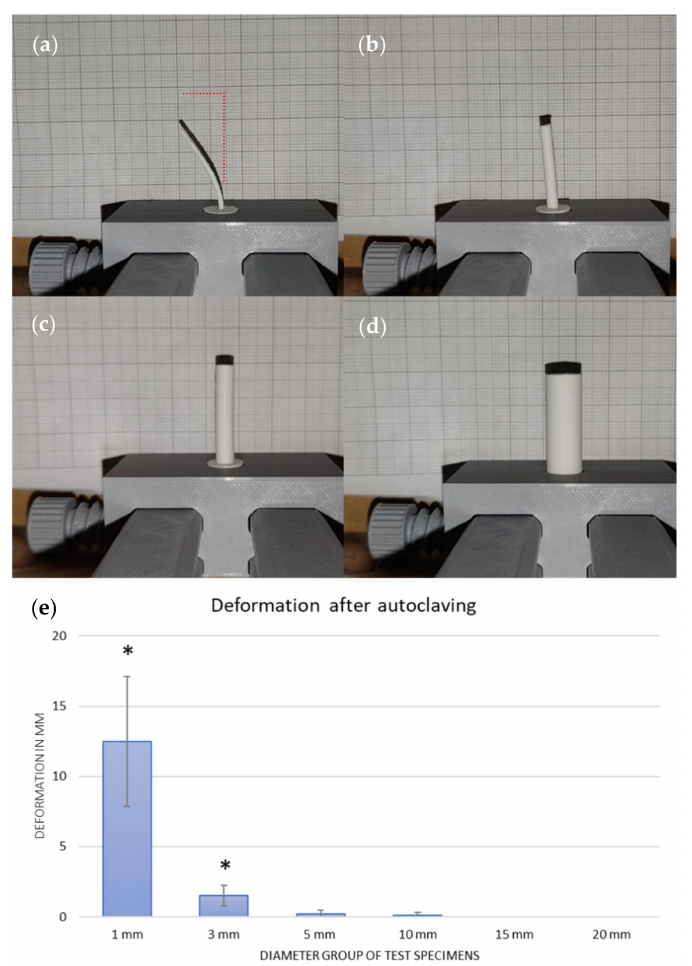
Figure 4. The reduction of the deviation with ascending diameter of the specimen can be seen. The specimens are rotated to their maximum degree of deviation, starting with 1 mm ( a ), 3 mm ( b ), 5 mm ( c ), and 10 mm ( d ). ( e ) A diagram which shows the resulting biggest deformation of one axis of the test specimen in mm and the related SD. After autoclaving, the groups with diameters ranging from 1 to 3 mm showed significant deformation (shown by